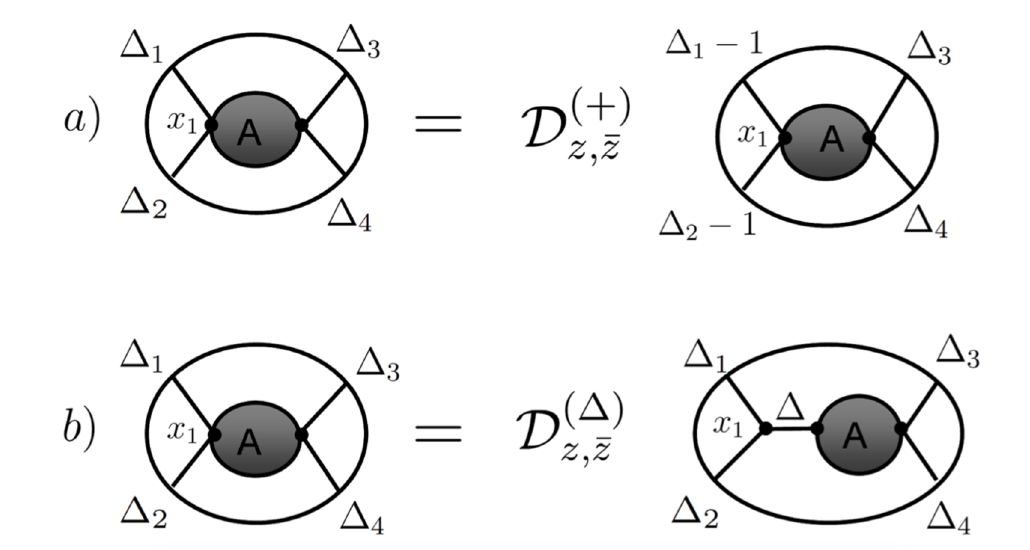
Figure 4 . a) Identity 2: The derivative operator raises the scaling dimension of the external